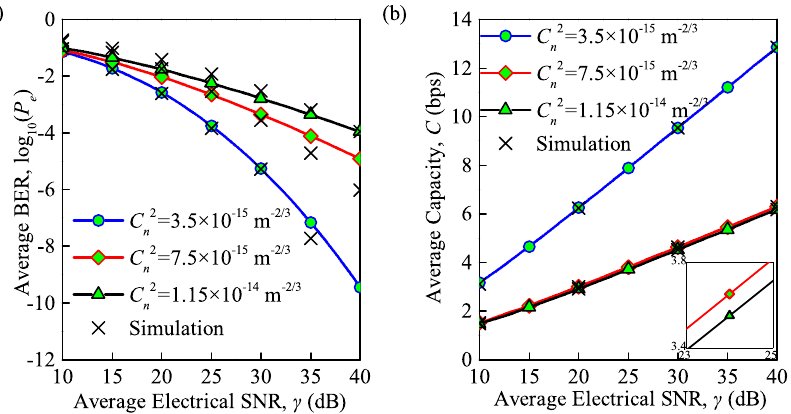
Figure 2. ( a ) Average BER versus normalized SNR for different structure constants; ( b ) average capac- ity versus normalized SNR for different structure constants ( λ = 850 nm, T e = 300 K, R b = 0.155 Gb/s).